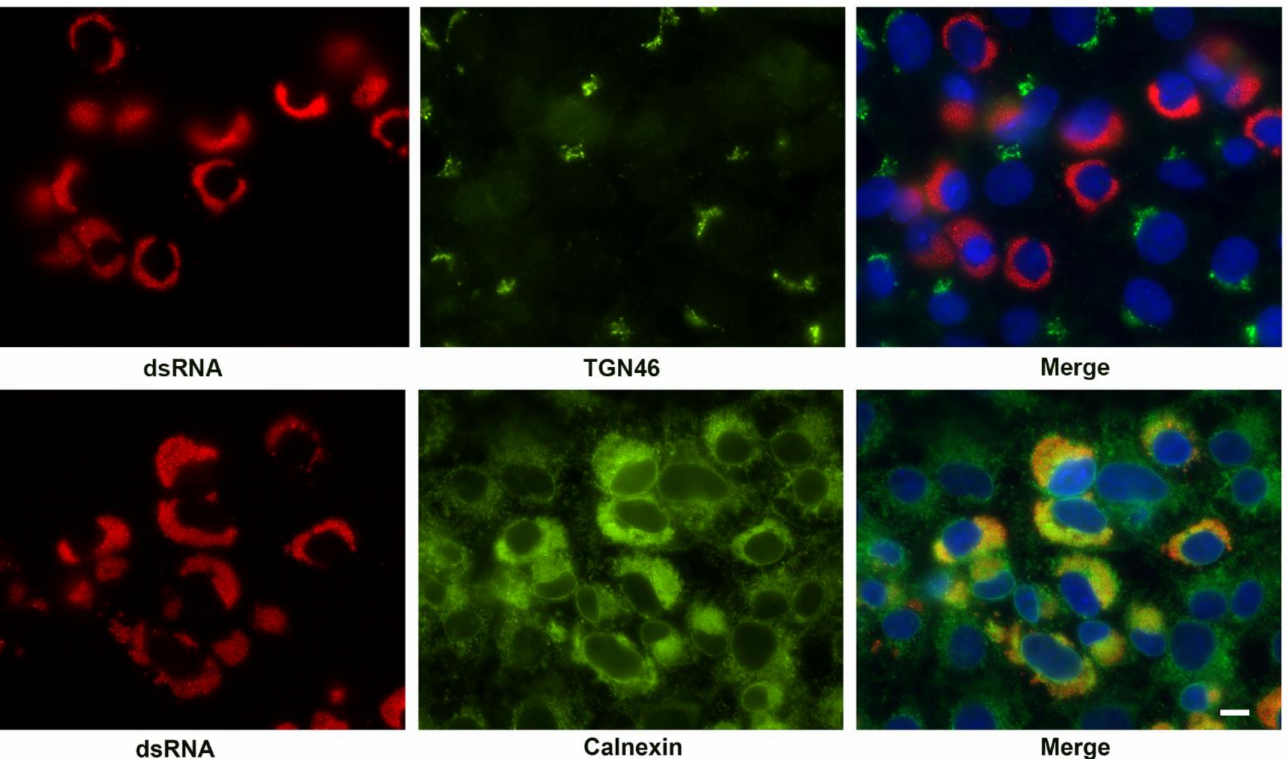
Figure 7. Immunofluorescent labeling of the SARS-CoV-2 replication complex at 24 h post-infection by antibody detecting dsRNA (red) and co-labeling with antibody to Golgi (TGN46) and ER markers (Calnexin). Cellular antigens are shown in green. The merged image is counterstained with DAPI (blue). Note the condensation of the ER and close association with the viral replication organelle. TGN46 appears only as diffuse background in infected cells. Bar = 10 µ